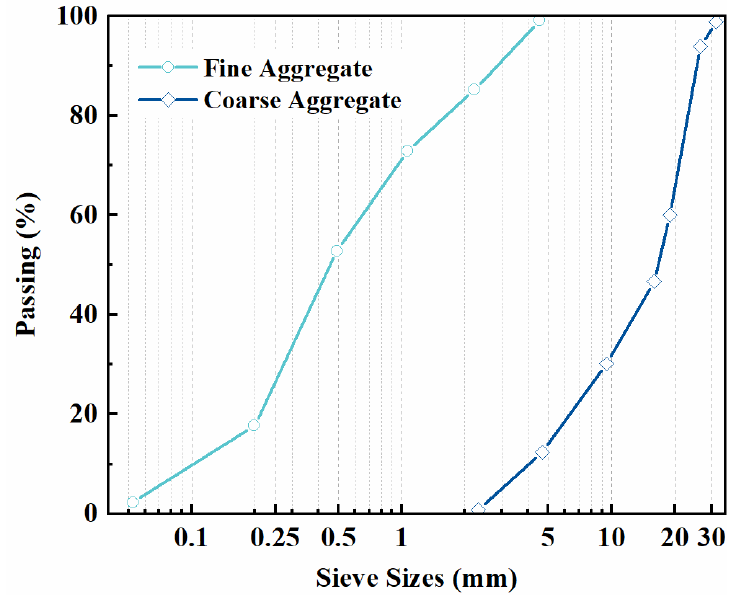
Figure 1. Particle size distribution of aggregates. Table 2. Concrete mix proportions (kg/m 3